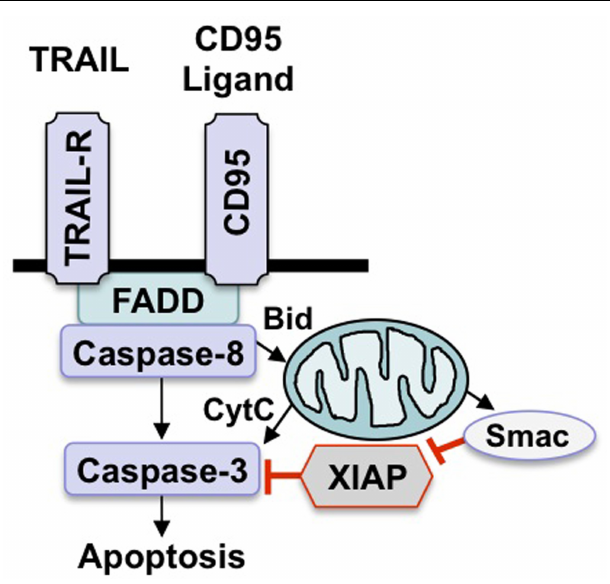
FIGURE 1 | Scheme of apoptosis pathways. There are two key apoptosis signaling pathways, i.e., the death receptor (extrinsic) pathway and the mitochondrial (intrinsic) pathway. Stimulation of death receptors by their cognate ligands leads to activation of caspase-8, which either directly activates downstream caspases or initiates the mitochondrial pathway by cleaving Bid. Engagement of the intrinsic pathway results in the release of mitochondrial proteins such as cytochrome c or Smac into the cytosol, which in turn promotes activation of caspase-3 and